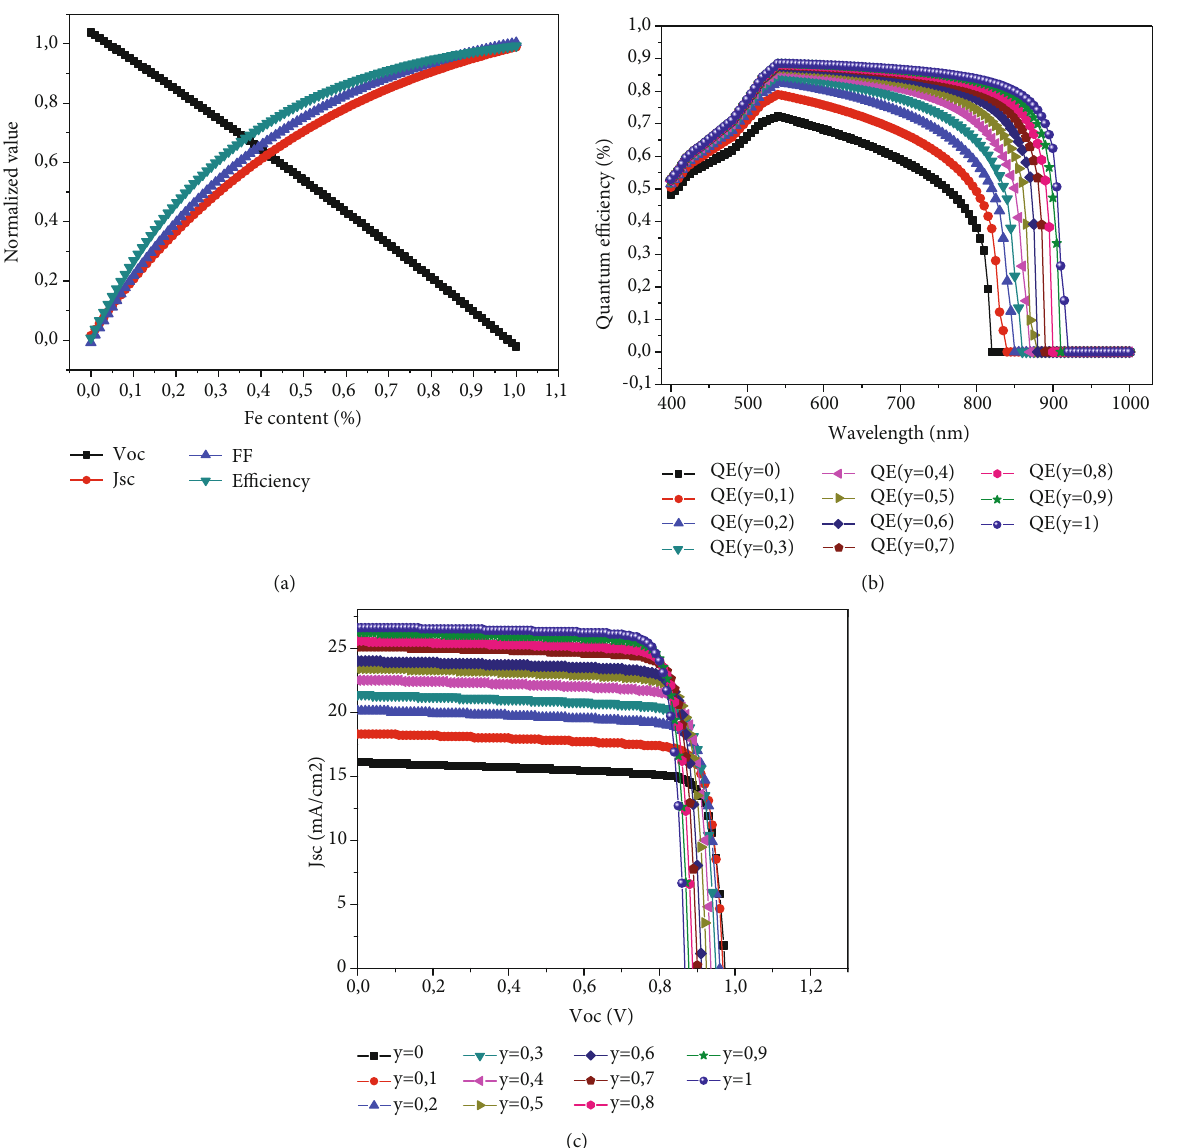
Figure 3: (a) Calculated normalized output parameters and quantum e ffi ciency of the CZFTS solar cells as a function of the Fe content and (b) variation of J-V characteristics with Fe